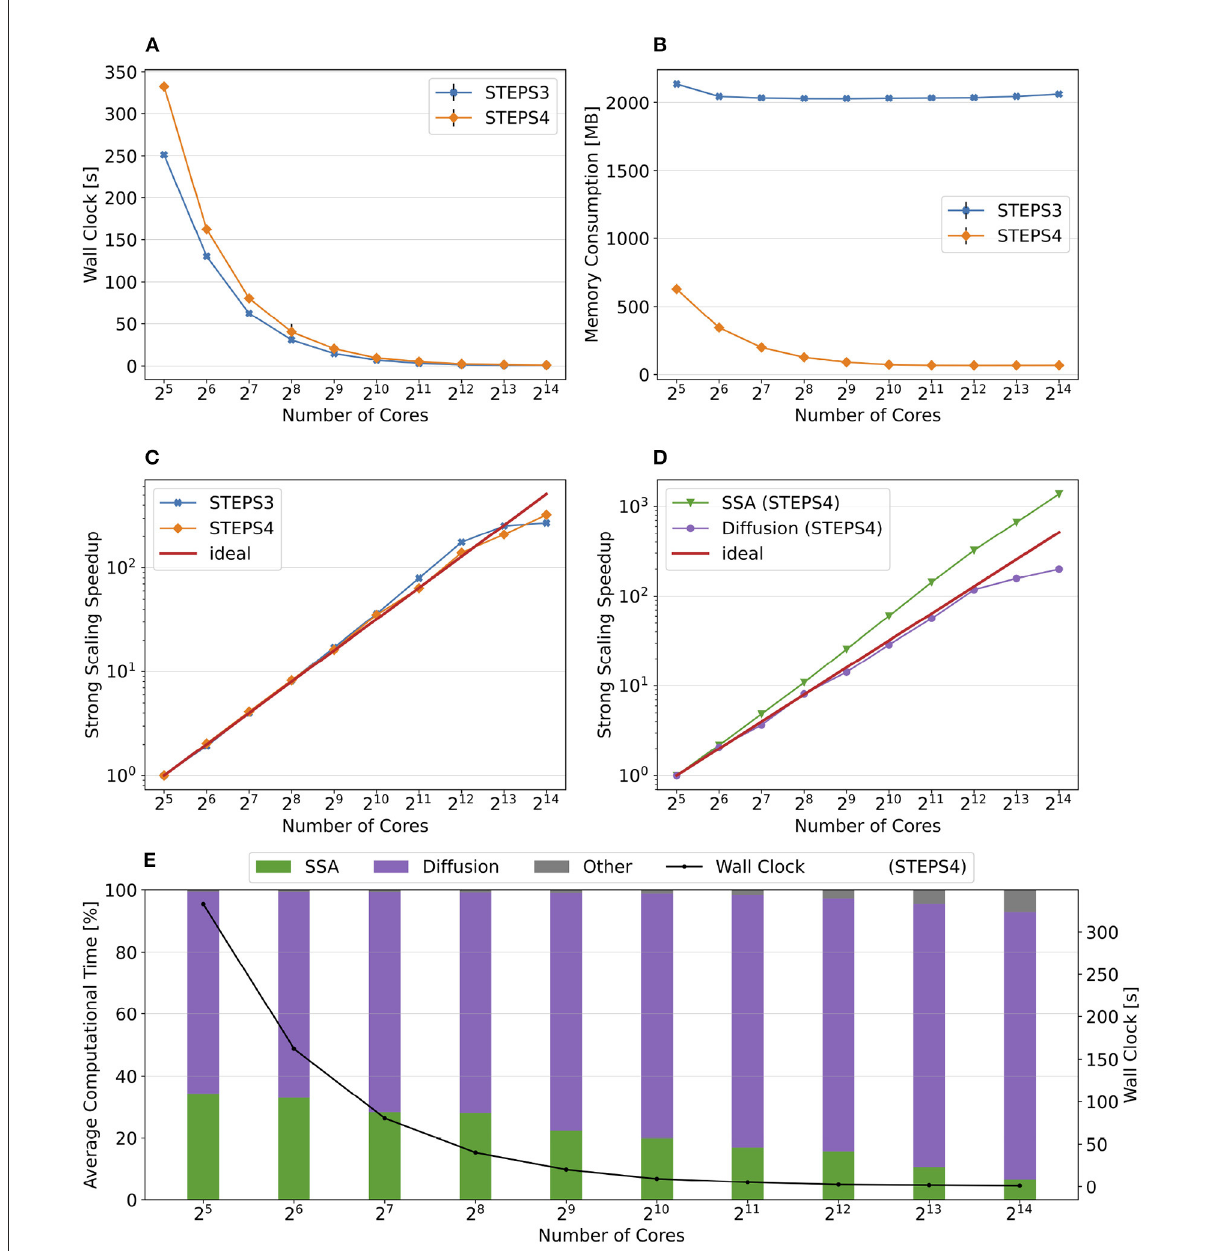
FIGURE9 The performance results and scalability of the calcium burst background model. (A) Steady decrease of simulation time cost can be observed in both STEPS 4 and STEPS 3 simulations. STEPS 4 performs slightly worse than STEPS 3 in low core count simulations, but both eventually achieve similar performance as core count increases. (B) The memory footprint of STEPS 4 is superior compared to the STEPS 3 counterparts, requiring about 630MB for 2 5 = 32 core simulations, and 67MB for 2 10 = 1,024 core and above simulations. STEPS 3 consumes more than 2GB of memory per core for the whole series. (C) Both STEPS 4 and STEPS 3 demonstrate linear to super-linear scaling speedup. (D) Component scalability analysis of STEPS 4 suggests that the diffusion operator in STEPS 4 exhibits linear speedup until 2 10 = 1,024 cores, while the SSA operator shows a remarkable super-linear speedup throughout the series. (E) Component proportion analysis of STEPS 4. The diffusion operator is the dominating component, taking from 65 to 95% of the overall computational time.